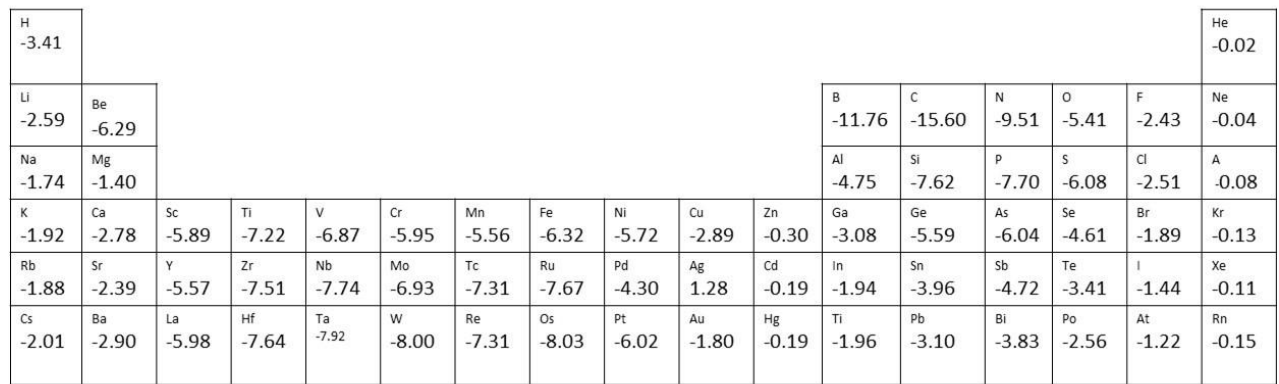
Figure 2. Adsorption energy (in eV/atom) for atoms at single vacancies of graphene calculated using WdW — DF2. Data were taken from Ref. [3].